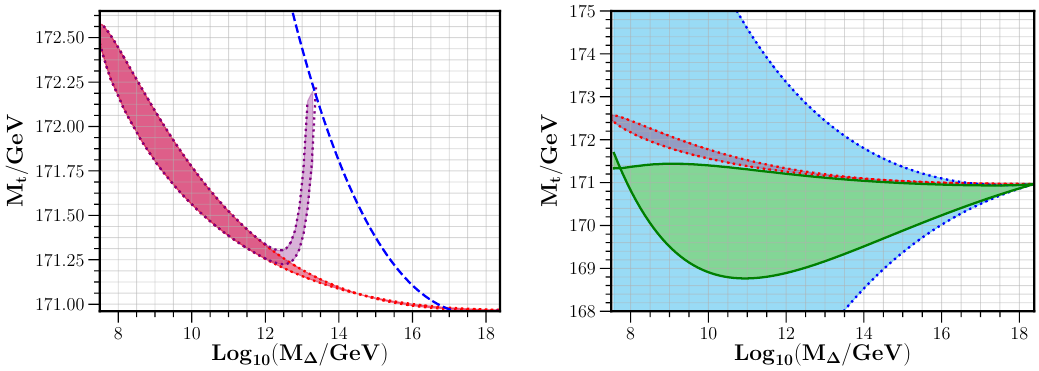
Figure 1 . Predicted range in the top quark mass from asymptotically safe quantum gravity assuming a Higgs mass of M H = 125 . 15 GeV . The predicted value of the top quark mass in the SM, M t ∼ 171 GeV , corresponds to the limiting case M ∆ = M pl . Left: in red we see the predicted bounds derived considering the SU (2) triplet alone and vanishing cubic coupling. In purple we present the bounds with the requirement that the mass of the light neutrinos mainly comes from the type II seesaw. The latter case implies bounds M t & 171 . 3 GeV and M ∆ . 5 × 10 13 GeV . In blue we show the maximum value for the top mass using the maximum value of the cubic coupling allowed by vacuum stability. Right: the vacuum stability of the full Higgs double-triplet potential requires the presence of right-handed singlet neutrinos. In red we show again the bounds using the triplet alone and vanishing cubic coupling. In blue we illustrate how the bounds change if the neutrino-Higgs Yukawa coupling Y Φ is equal to the top-Higgs Yukawa coupling at the intermediate scale. The blue lower bound corresponds to a vanishing cubic coupling at the triplet scale. This bound depends on the value of Y Φ , with smaller Y Φ pushing the bound upwards. A shift of the bound in the same direction occurs if the right-handed neutrino masses are larger than the triplet mass. The blue upper bound corresponds to the maximum value that the cubic coupling can attain, for a vanishing quartic doublet coupling at the triplet scale M ∆ . The solid green curves obtain for a vanishing cubic coupling at the Planck scale, for two values of the doublet-neutrino coupling Y Φ and right handed neutrino mass M ν = M ∆ . For larger M ν the allowed interval in between the curves